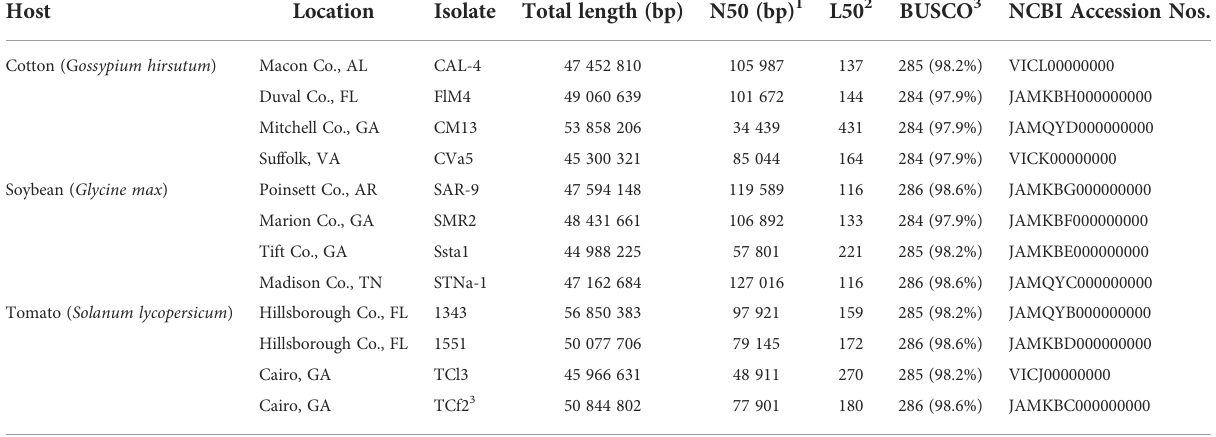
TABLE 1 Origin and basic metrics of the assembled Corynespora cassiicola